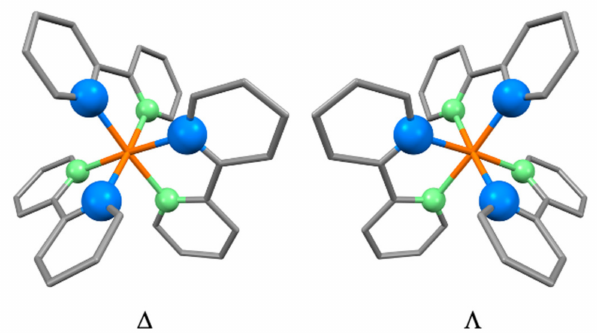
Figure 9. The absolute configurations of the two enantiomers of the [Ru(bpy) 3 ] 2+ cation. The green atoms of each bpy ligand are further away from the observer, and the blue atoms are closer. The cation resembles a propeller, with each blade being defined by the donor atoms of the bpy ligands. An anti-clockwise rotation of the right-hand structure will “dig” the propeller into the page. This is the Λ -isomer. The mirror-image propeller on the left must be rotated clockwise to do so, and is the denoted ∆